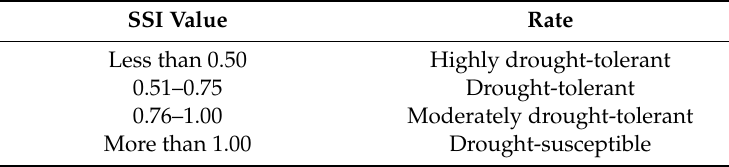
Table 1. Description of stress susceptibility index (SSI) value (Source: